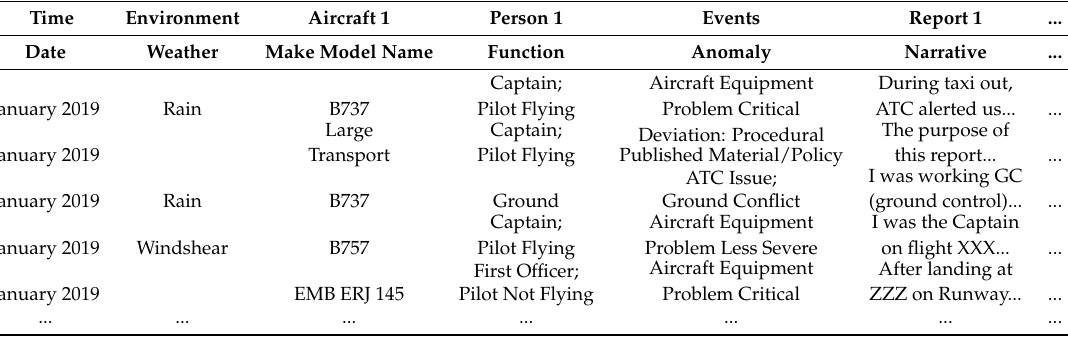
Table 1. Sample Aviation Safety Reporting System (ASRS) table including select relevant